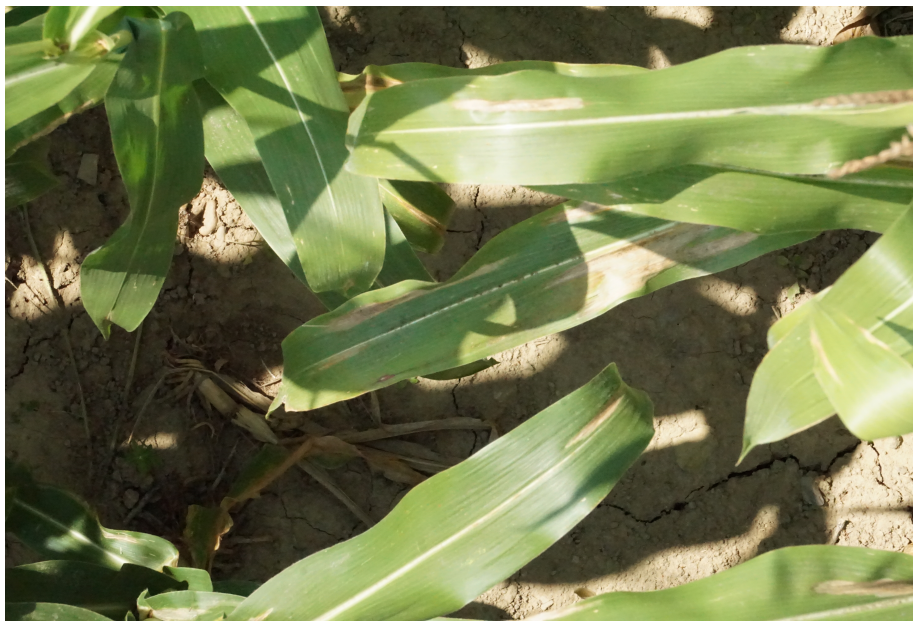
Figure A1. Typical full-size image (4000 × 600 pixels) of NLB symptoms from which individual lesions were cropped to generate the training